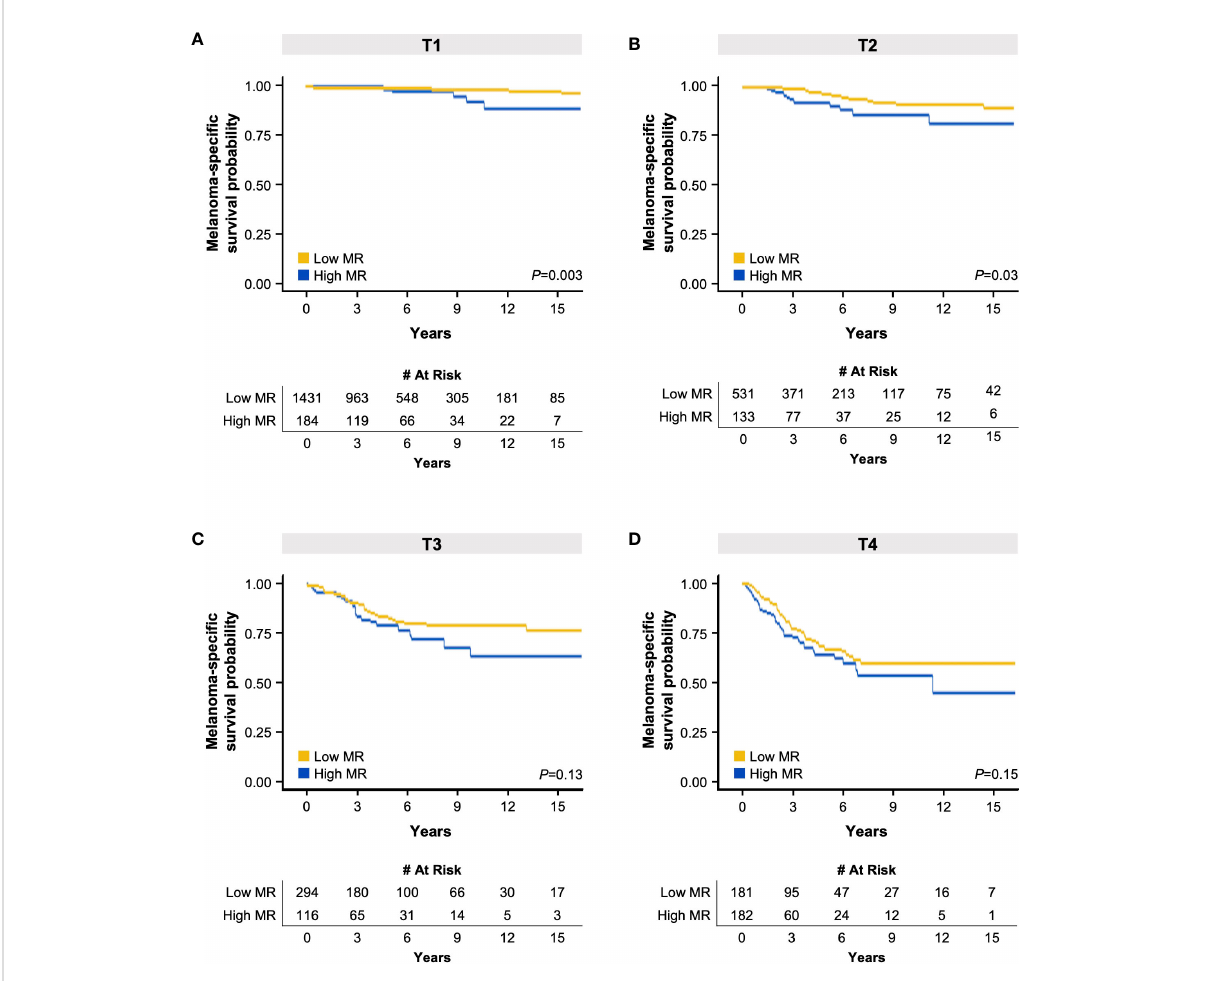
FIGURE 1 Kaplan-Meier melanoma-speci fi c survival curves based on high or low mitotic rate (MR) in patients with T1 (A) , T2 (B) , T3 (C) , and T4 (D) melanoma. The tables below each respective graph indicate the number of patients at risk over the speci fi ed elapsed time (years) up to 15 years.